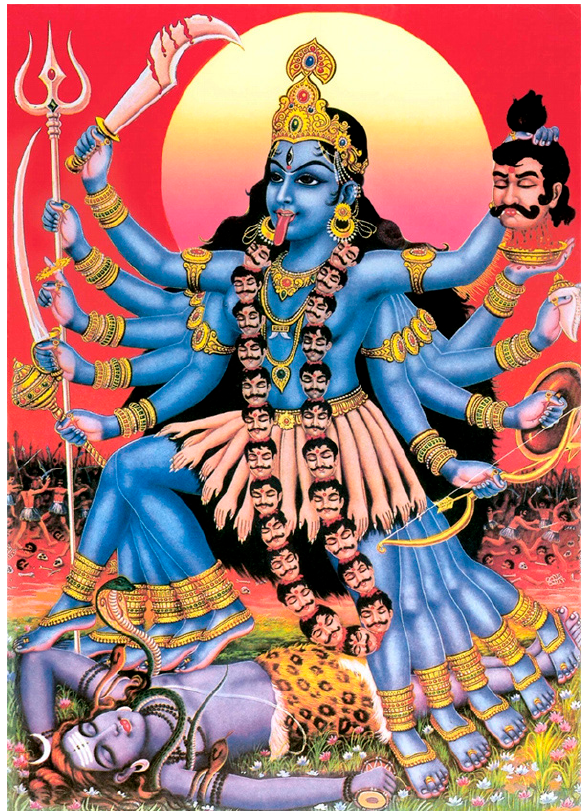
Figure 2. K ā l ī , poster art (in the author’s collection). Figure 2. K¯al¯ı, poster art (in the author’s